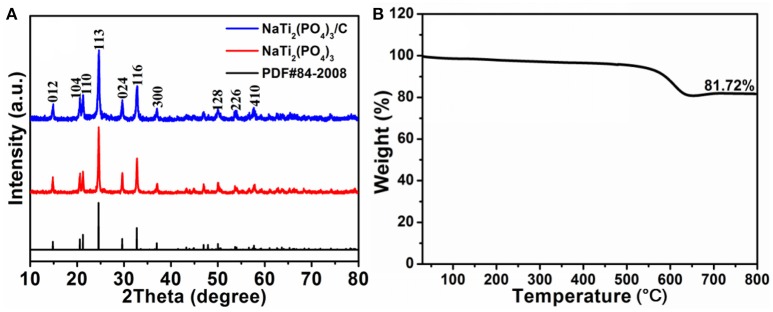
(A) XRD patterns of NaTi2(PO4)3 and NaTi2(PO4)3/C; (B) TG curve of NaTi2(PO4)3/C.